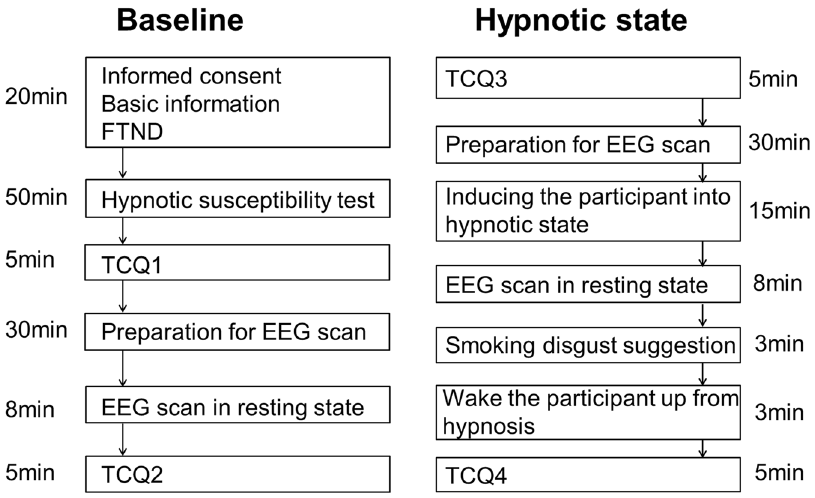
Figure 3. The flow chart of the experiment. FTND: Fagerström Test for Nicotine Dependence; TCQ: Tobacco Craving